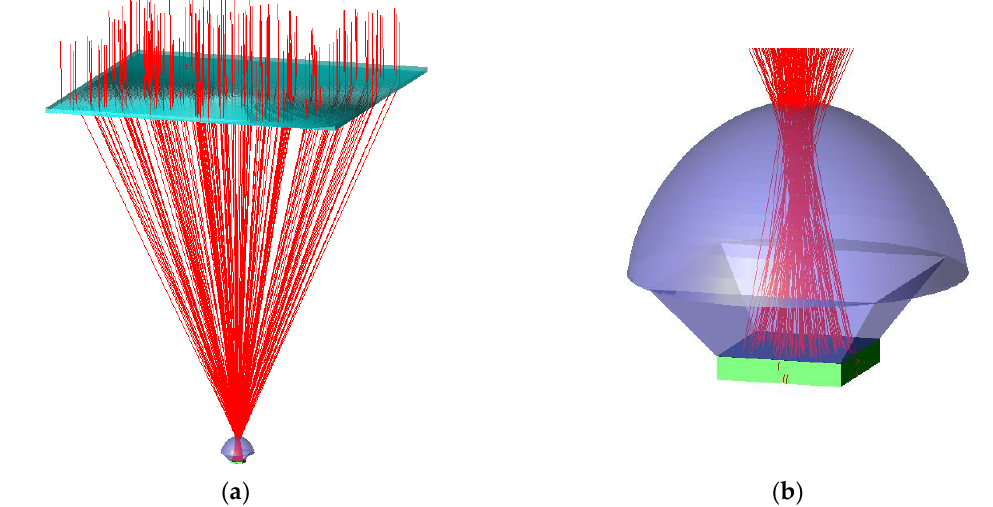
Figure 2 . ( a ) ray tracing, at scale, of the HCPV unit analyzed; ( b ) detail of the concentrated rays at the secondary optical element and impinging on the multi-junction solar cell.